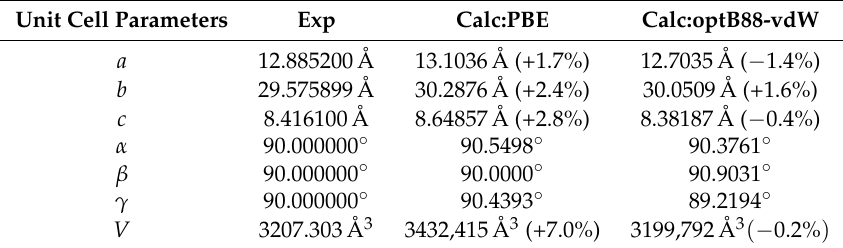
Table 4. Unit cell parameters of κ -Cl obtained from X-ray diffraction measurements at 100K (left column), ab initio calculations based on the PBE functional (central column) and on the optB88-vdW functional (right column). In both types of calculations, the pseudopotentials denoted as choice (2) were used. Relative deviations from experimental values are given in